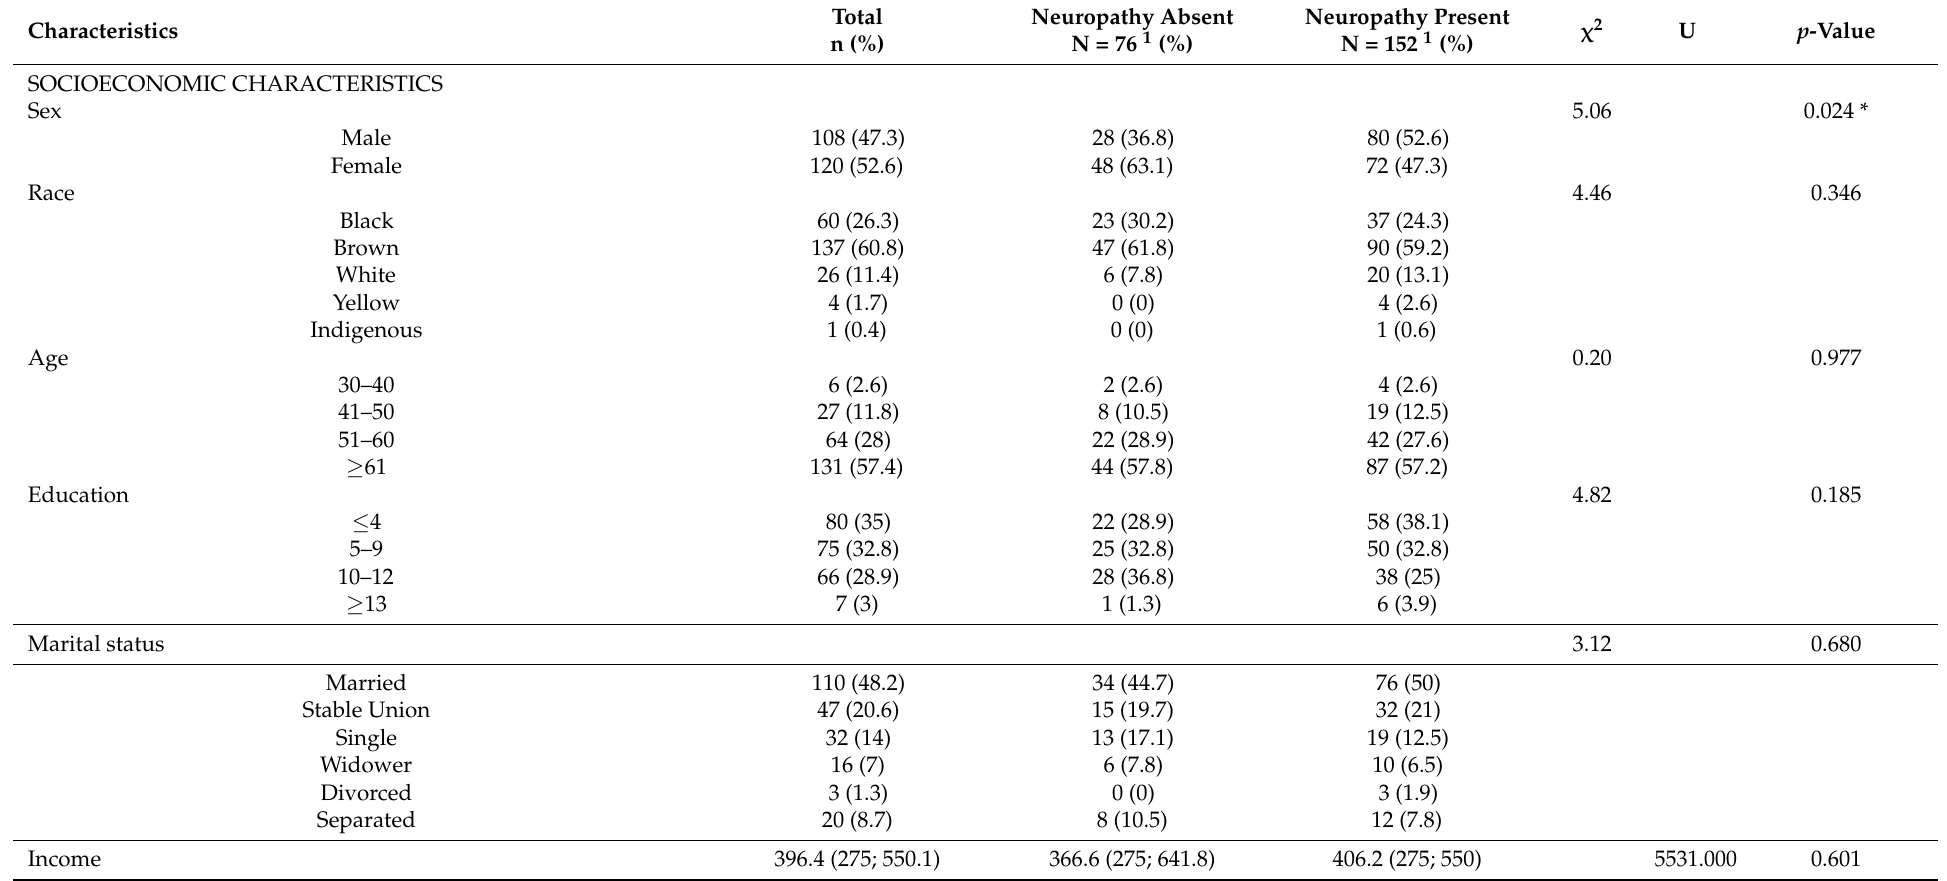
Table 1. Socioeconomic and clinical characteristics and health habits, biochemical parameters of the participants and perception of self-care in diabetes.